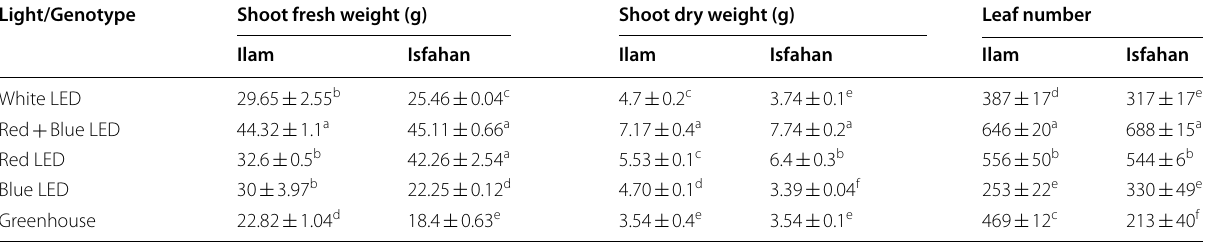
Table 2 Interaction of genotype and light on growth indices in two lemon balm genotypes under different levels of light (Data in the table represent means SE and different letters indicate a significant difference at the probability level of 0.05 based on LSD test) ±